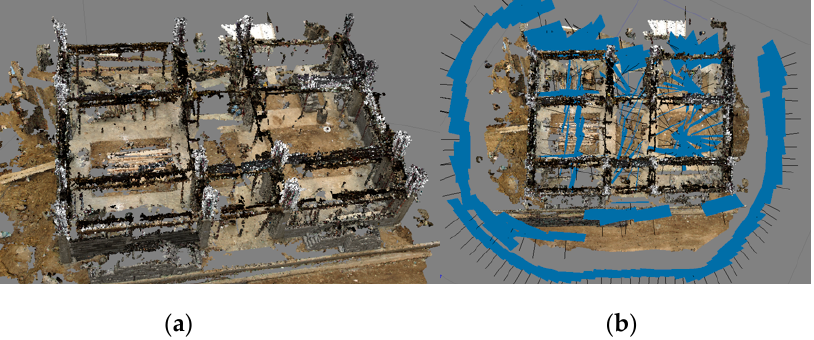
Figure 4. Generated point could for the first case study: ( a ) The sparse point cloud, ( b ) the dense point cloud.